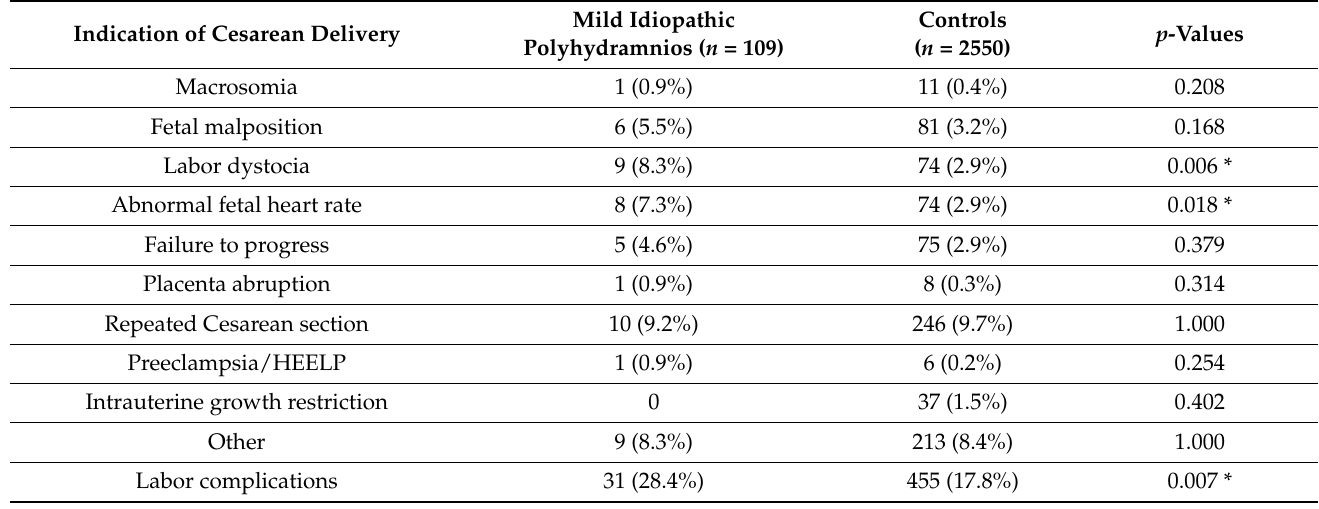
Table 3. Indication to Cesarean section in cases and controls.